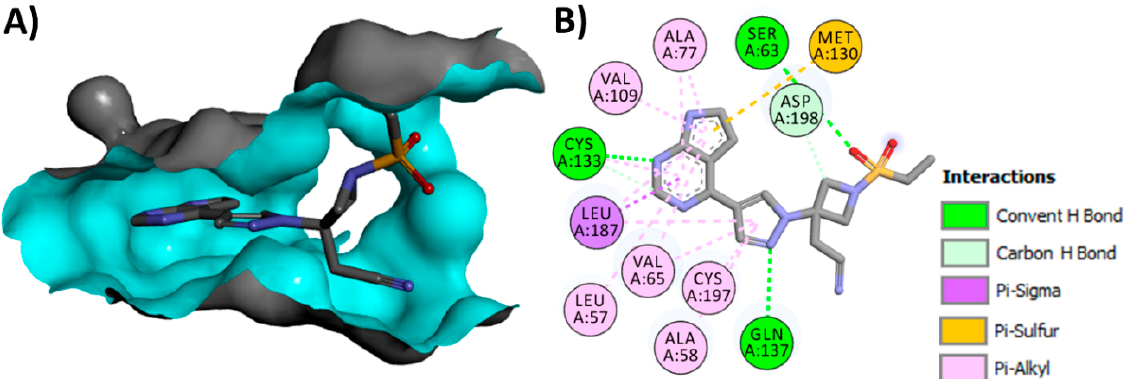
Figure 18. Binding modes of baricitinib (shown as sticks) into BMP-2-inducible kinase (pdb: 4W9X): ( A ) 3D binding mode, receptor shown as a hydrogen bond surface; ( B ) 2D binding mode showing different types of binding interactions with amino acids in BMP-2-inducible kinase; this figure was generated using Discovery Studio Visualizer (V16.1.0.15350).